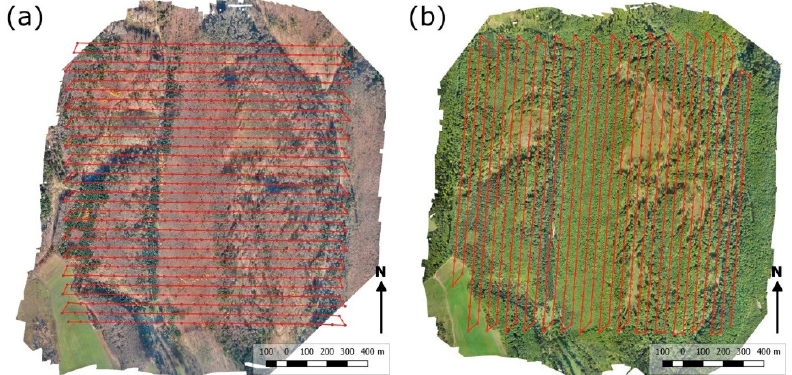
Figure 2. Flight patterns used in the study: ( a ) represents pattern FP1 perpendicular to the valleys, ( b ) pattern FP2 parallel to the valleys. These are rendered over orthomosaicked images acquired under leaf-off (a) and leaf-on (b) conditions. Both patterns were used under both vegetation leaf-off and leaf-on conditions. A combined pattern (FP12) was also used during the evaluation.